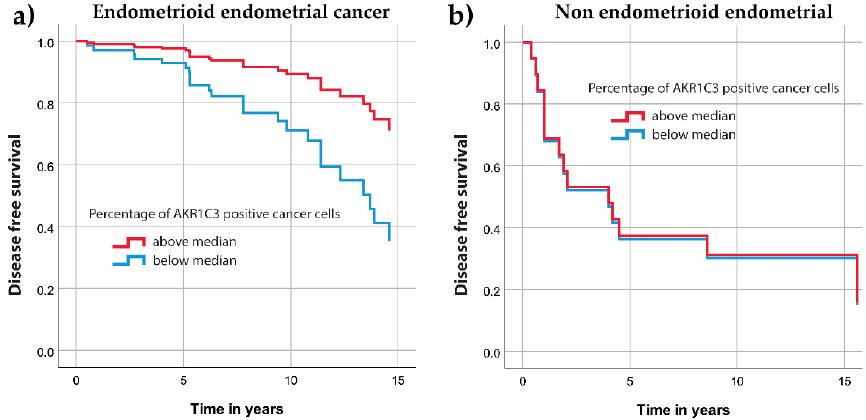
Figure 5. Disease-free survival curves for the AKR1C3 groups separated according to the median value. ( a ) Patients with endometrioid endometrial cancer. ( b ) Patients with nonendometrioid endometrial cancer.